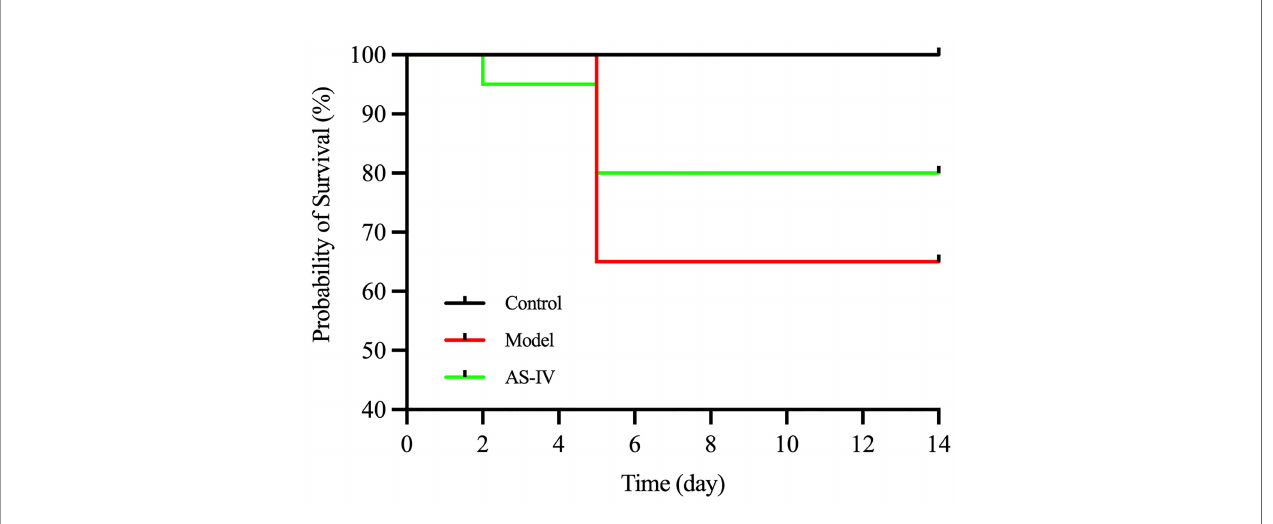
FIGURE 2 | The survival rate in mice on day 14.